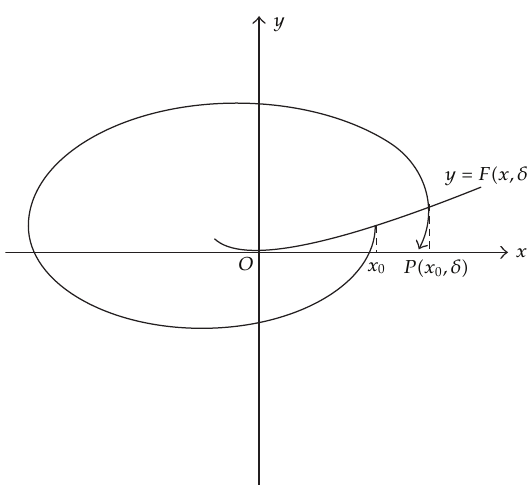
Figure 1: The Poincar´e map of (cid:4) 1.21 (cid:5) with x 0 >